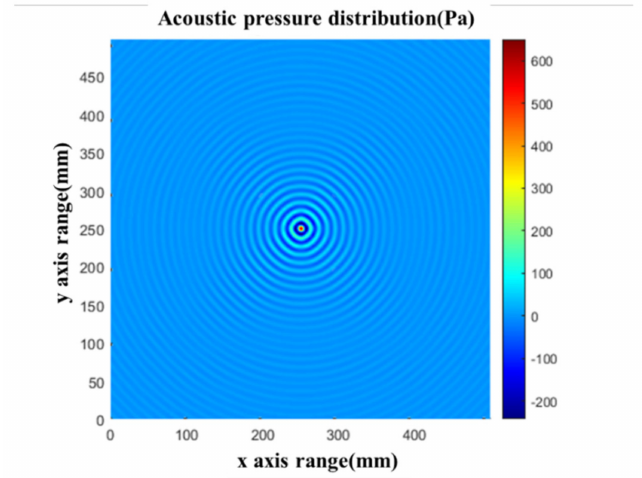
Figure 12. Acoustic pressure distribution in the pMUT array